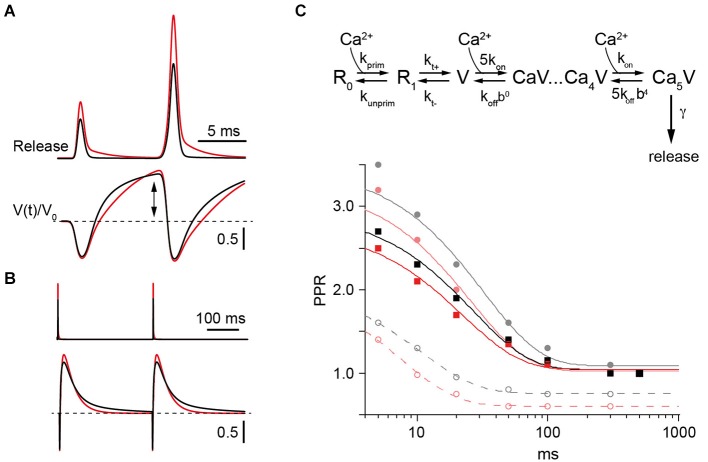
Model of PPF in WT and CR−/− synapses. (A) Upper: Simulated transmitter release rates during a pair of synaptic activations at an ISI of 10 ms in WT (black) or CR−/− synapses (red) normalized to the first release process in the WT. Lower: Temporal variation of Ca2+-free release sensor sites (V(t)) normalized to their value prior to the first stimulus (V0) during 100 Hz activation in WT (black) or KO synapses (red). Note the increase (arrow) above V0 (dashed line) between pulses. (B) Same as in (A) but for two activations with an ISI of 300 ms. (C) Upper: Scheme of the model which includes a release sensor with 5 Ca2+ binding sites (V) and a two-step replenishment (R0, R1) with the first step being Ca2+ dependent and the second step indirectly Ca2+ dependent (Millar et al., 2005; Sakaba, 2008). Lower: Paired pulse ratios (PPRs) calculated as the ratio of release probabilities between the second and the first pulse plotted against the ISI. Lines represent exponential fits. Curves for the WT are in gray and black and those for the CR−/− in red. Solid gray and light red curves represent simulations with koff set to 1000 s−1 (Millar et al., 2005). The corresponding PPRs result from the combined action of Ca2+ remaining bound to the release sensor (active Ca2+) between stimuli at small ISI (dashed lines) and overfilling of the pool V (cf. (A)). Increasing koff to 3500 s−1 eliminated facilitation due to active Ca2+ and resulted in the black and red curves for the frequency dependence of PPR in WT and KO, respectively. Irrespective of model details only slightly decreased facilitation is predicted for the KO in comparison to the WT.